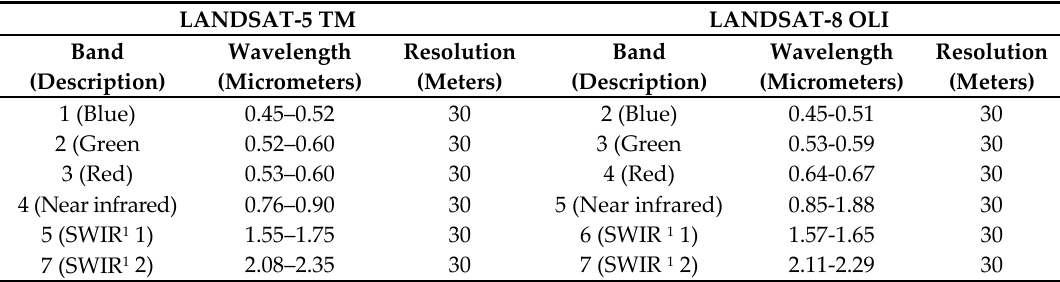
Table 1. Equivalence between Landsat-5 TM and Landsat-8 OLI bands. Only the bands that have been used in the study are